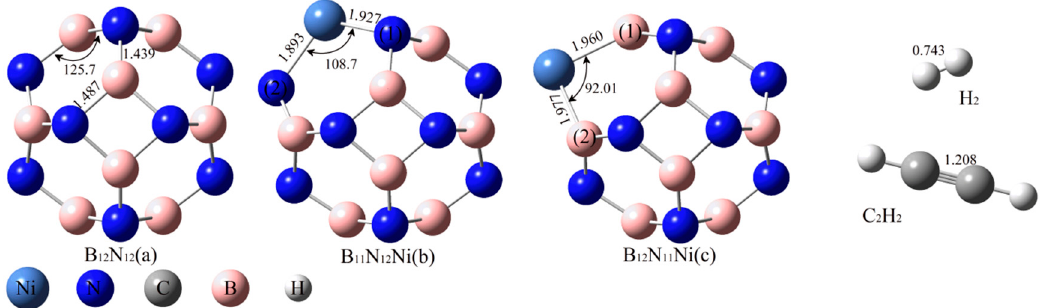
Figure 1. The optimised structures of undoped B 12 N 12 cluster ( a ), B 11 N 12 Ni ( b ) and B 12 N 11 Ni ( c ). H atom is white; B atom is pink; C atom is grey; N atom is mazarine; Ni atom is blue.